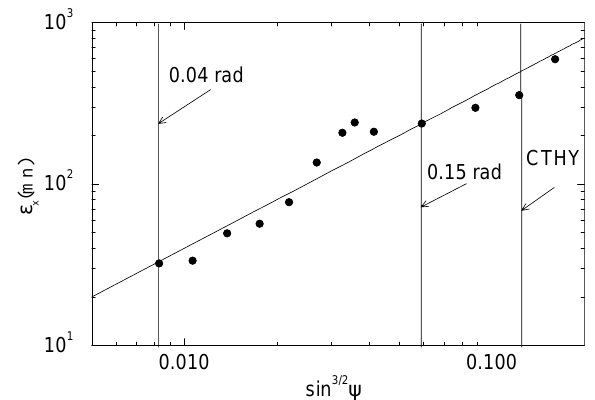
FIG. 11. A comparison between the sin 3 (cid:3) 2 c law, indicated by the line, and the data for the horn model.